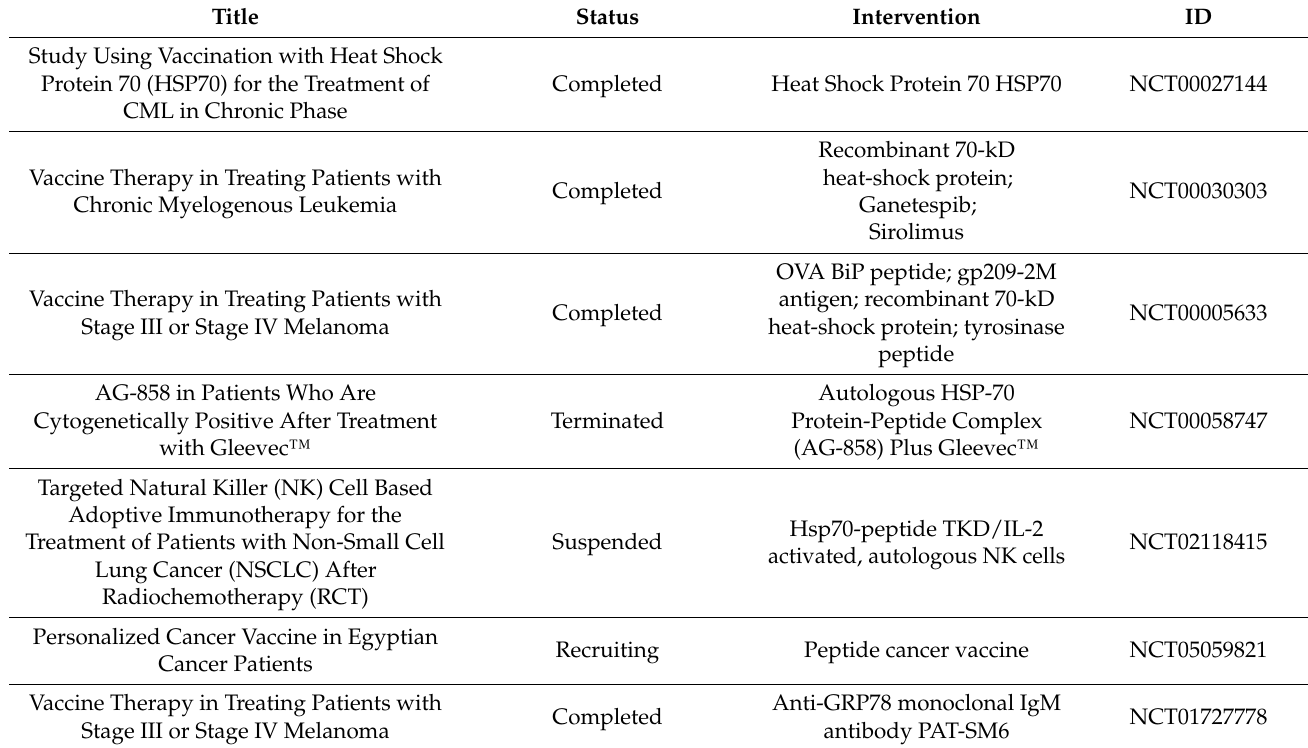
Table 3. Therapeutic clinical trials testing Hsp70 and/or Grp78 (BiP)